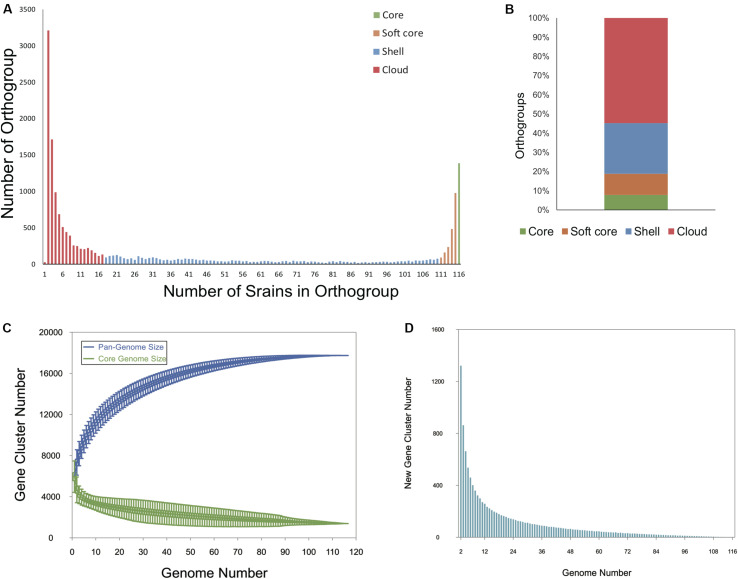
Pan -genome analysis of 116 Bcc whole-genome sequences. (A) Bar plot showing the frequencies of orthologous clusters. (B) Stacked bar plot of percentage of orthogroups in core, soft core, shell, and cloud genomes. (C) Gene accumulation curves of the Bcc pan- (blue) and core-genome (green). The estimation was made by including genomes one by one. (D) Quantitative relationship between new genes and sequenced genomes.